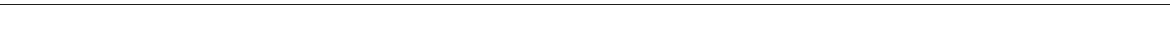
Fig. 3 VTA DA neuron excitability mediates the reinforcing properties of nonfamiliar conspeci fi c. a Experimental protocol for conditioned place preference with different stimuli. b Representative occupancy plots. c Scatter plot of preference score measured for familiar mouse pairing during CPP. Paired t test ( t (9) = 0.2086; mean and s.e.m for Pre-TEST: 0.498 ± 0.0298; mean and s.e.m for Post-TEST: 0.506 ± 0.0562). d Scatter plot of preference score for nonfamiliar conspeci fi c pairing during CPP. Paired t test ( t (9) = 4.578; mean and s.e.m for Pre-TEST: 0.497± 0.0144; mean and s.e.m for Post-TEST: 0.596 ± 0.0285). e Scatter plot of preference score for novel object pairing during CPP. Paired t test (t (9) = 2.263; mean and s.e.m for Pre-TEST: 0.510± 0.0430; mean and s.e.m for Post-TEST: 0.403 ± 0.0455). f Time course of interaction during conditioning blocks with a familiar mouse (f1). Friedman test ( P = 0.0150; x 2 (12) = 23.51). g Time course of interaction during conditioning blocks with a nonfamiliar conspeci fi c (s1). Friedman test ( P < 0.0001; x 2 (12) = 52.71). h Time course of interaction during conditioning blocks with a novel object (o1). Friedman test ( P = 0.0008; x 2 (12) = 31.88). i Cumulative interaction during conditioning sessions at day 1 and day 4, respe – Wallis test (K (6) = 46.09, P < 0.0001) followed by Dunn ’ s test for planned comparisons. j Left: experimental protocol for VTA::DA hM4Di and VTA::DA mCherry treated with CNO during CPP with nonfamiliar conspeci fi c pairings. Right: representative occupancy plots for CNO treated VTA::DA mCherry and VTA::DA hM4Di . k Scatter plot of preference score for VTA::DA mCherry treated with CNO during conditioning sessions with a nonfamiliar conspeci fi c (mean and s.e.m for Pre-TEST: 0.4808 ± 0.0267; mean and s.e.m for Post-TEST: 0.5836± 0.0275), and scatter plot of preference score for VTA::DA hM4Di treated with CNO during conditioning sessions with a nonfamiliar conspeci fi c (mean and s.e.m for Pre-TEST: 0.4903 ± 0.0162; mean and s.e.m for Post-TEST: 0.5091 ± 0.0428). RM two-way ANOVA (time main effect: F (1, 24) = 7.7048, P = 0.0105; virus main effect: F (1,24) = 0.8678, P = 0.3609; time × virus interaction: F (1,24) = 3.2861, P = 0.0824) followed by Bonferroni post hoc test for planned comparisons. N indicates number of mice. Error bars represent